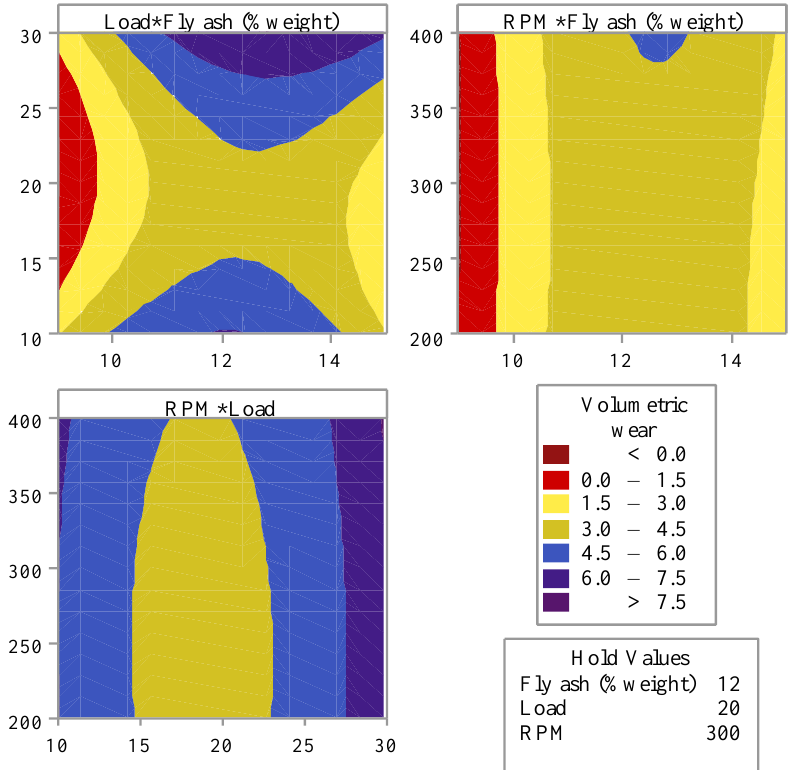
Figure 16. Variation in wear w.r.t. input parameters.